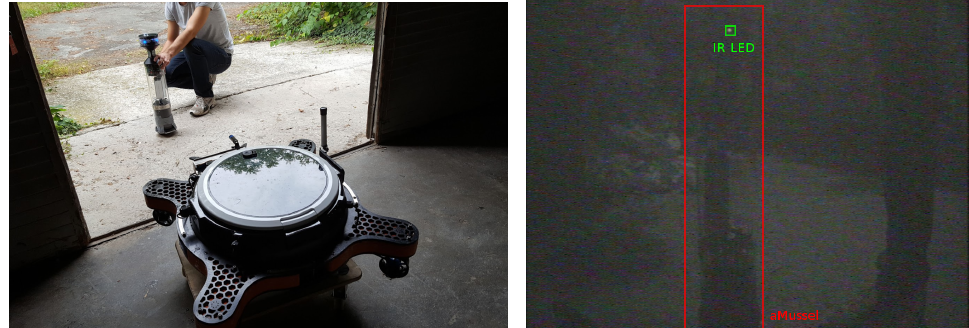
Figure 5. Initial docking vision system test for IR filtering in daylight. Only one camera and docking mechanism mounted for proof-of-concept purposes ( left ), and an example image of aMussel outdoors in ambient sunlight with IR LED in cap turned on, viewed through an analog camera with IR filter applied ( right ).